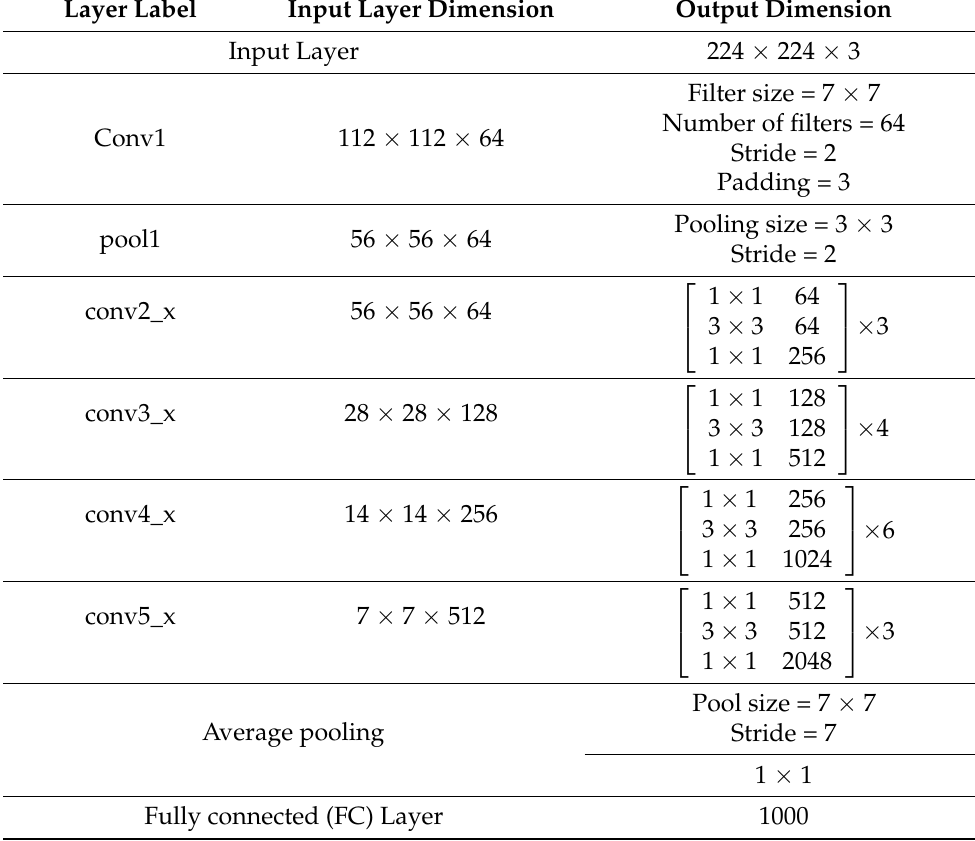
Table 2. The dimensions of the various layers of ResNet 50